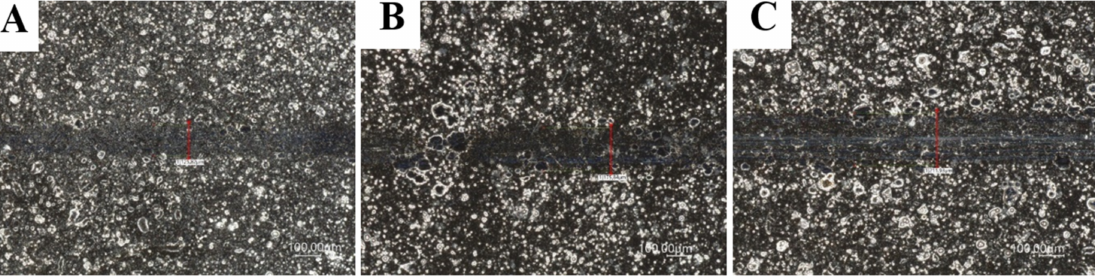
Figure 8. Images of cracks for samples with NiP/Si 3 N 4 coatings deposited in a bath with 5 g/dm 3 Si 3 N 4 (load: ( A ) 5 N; ( B ) 10 N; ( C ) 15 N; magnification: 500 ×